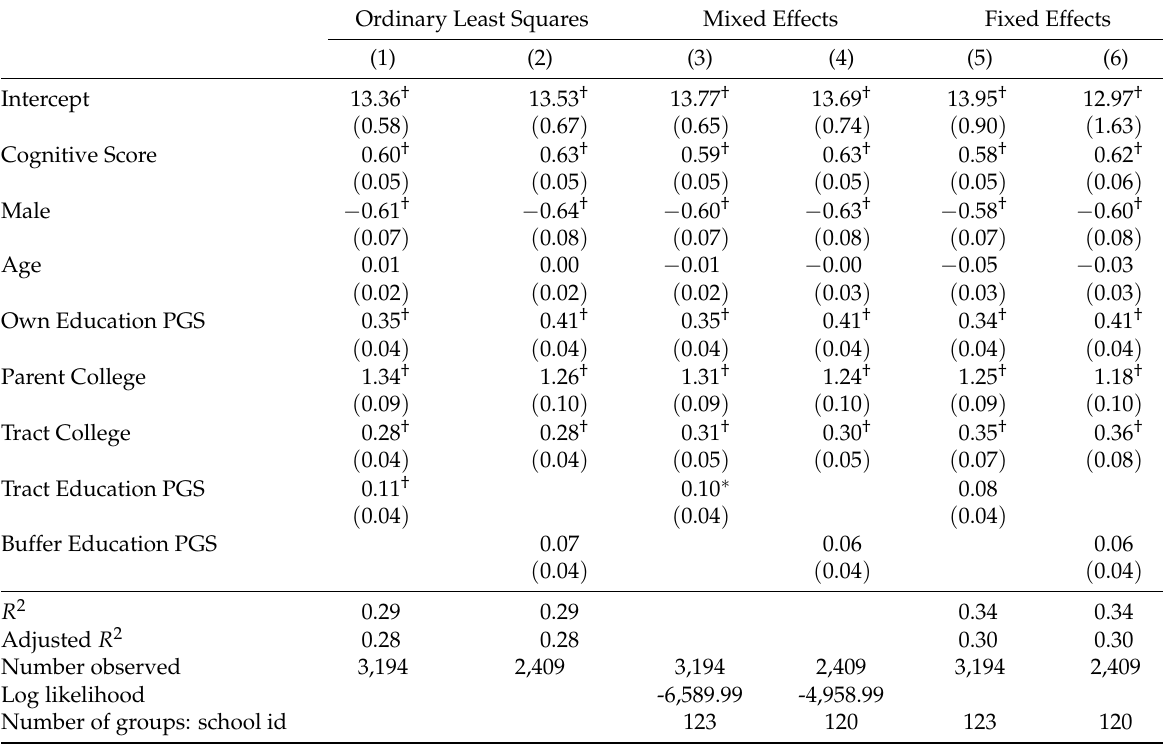
Table 5: Years of education at wave 4; linear